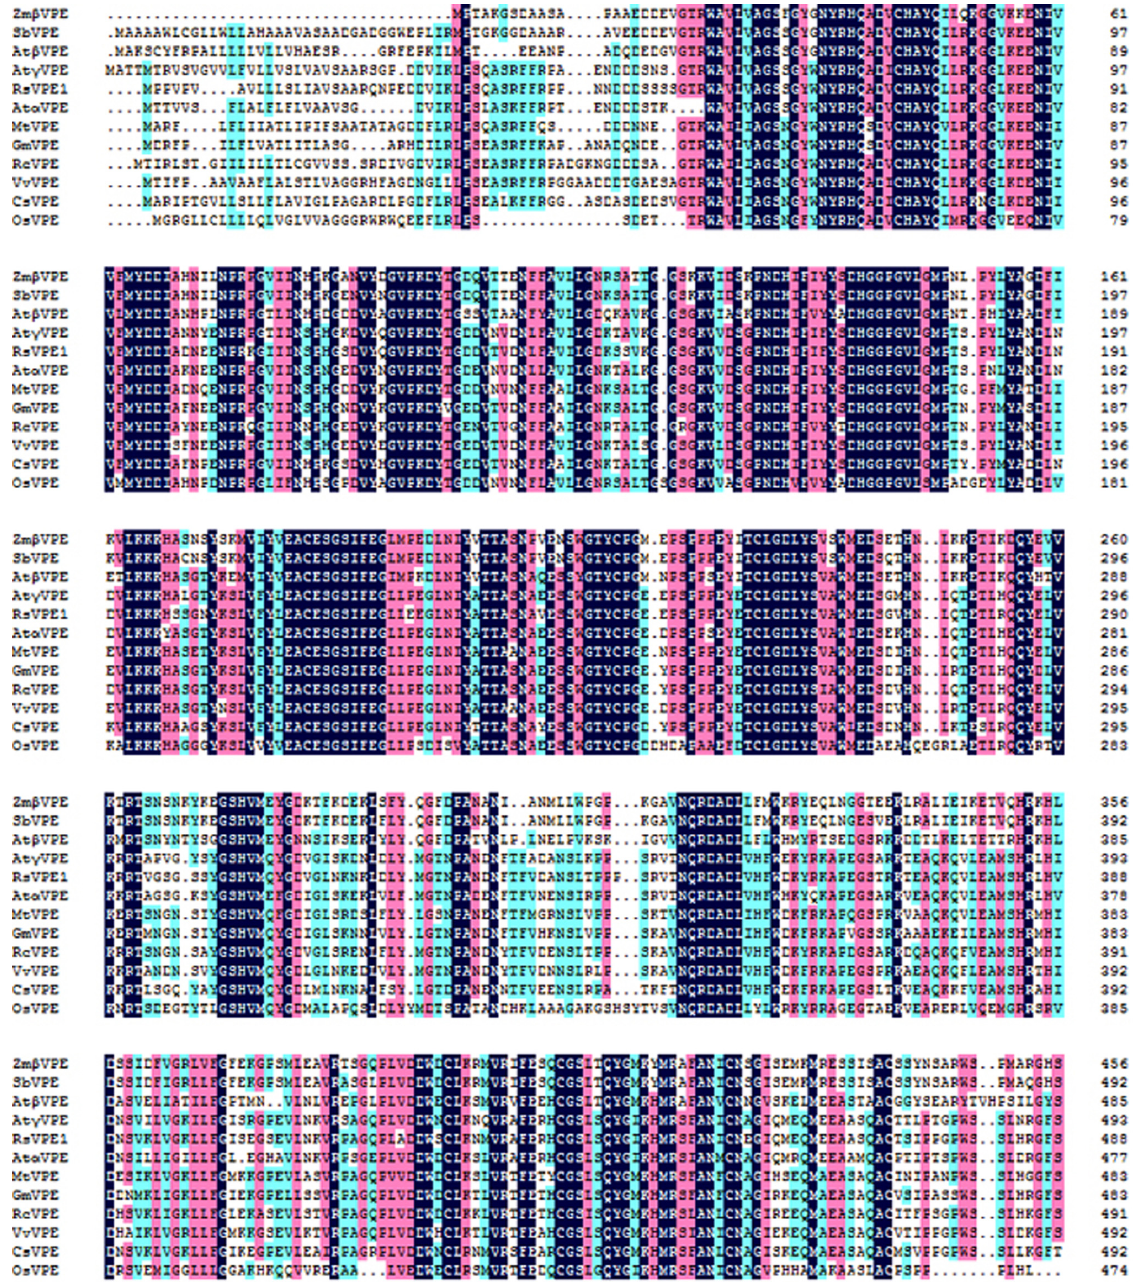
Figure 3. Comparison of the predicted protein sequence of RsVPE1 with other vacuolar processing enzyme (VPE) proteins. The accession numbers of these proteins in the GenBank database are as follows: At α VPE (NP_180165.1), At β VPE (NP_176458.1), At γ VPE (NP_195020.1), CsVPE (XP_004142919.1), GmVPE (XP_003525979.1), MtVPE Arabidopsis thaliana ; Cs, Cucumis sativus ; Gm, Glycine max ; Mt, Medicago truncatula ; Os, Oryza sativa ; Rc, Ricinus communis ; Rs, Raphalus sativus ; Sb, sorghum bicolor ; Vv, Vitis vinifera ; Zm, Zea mays . Black indicates identical amino acids among the different species. Pink and blue represent similar amino